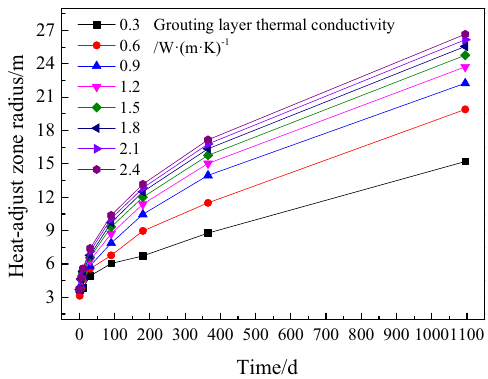
Figure 9: Influence of grouting layer thermal conductivity on heat - adjusting zone